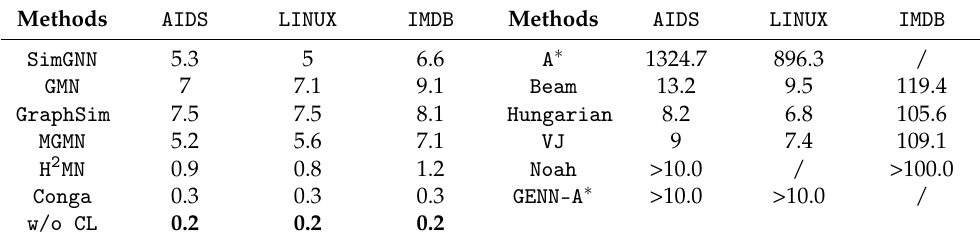
Table 4. Efficiency comparison. The values denote average time consumption on one pair of graphs in milliseconds . / represents that the results cannot be obtained due to excessive running time or are not provided in the original work (and cannot be